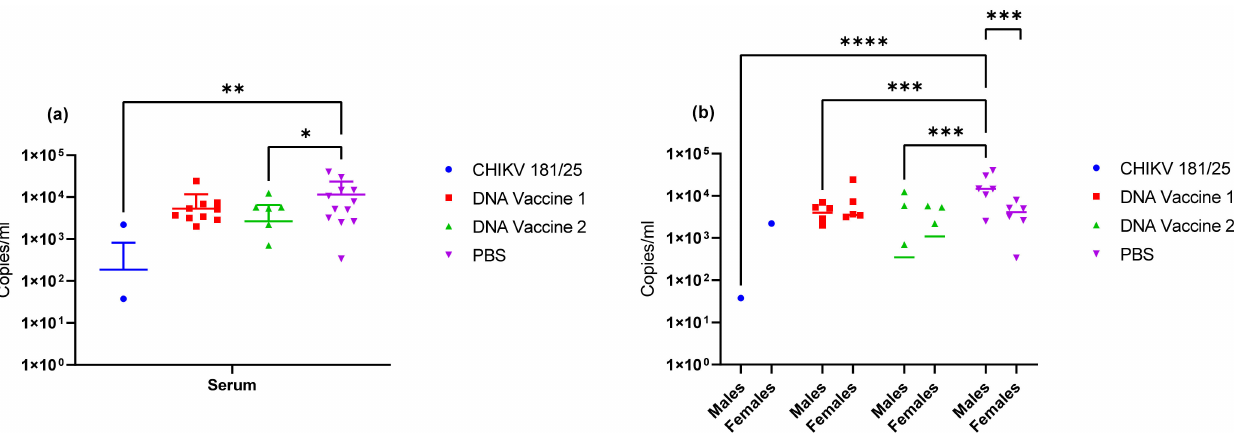
Figure 10. Viral RNA concentrations in serum collected on day 3 post-challenge. ( a ) Viral RNA copy number in vaccinated versus unvaccinated animals. ( b ) Viral RNA copy number in male versus female animals. * p < 0.05, ** p < 0.005, *** p < 0.0005, **** p <